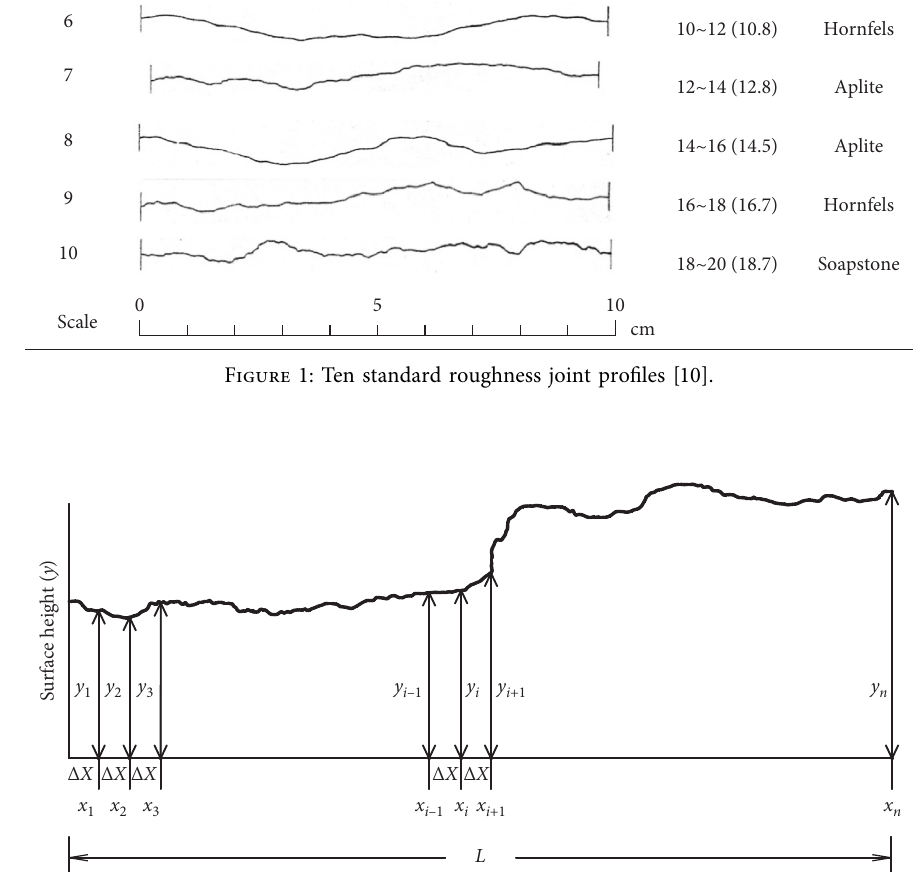
Table 1: Comparison of relationships of Z